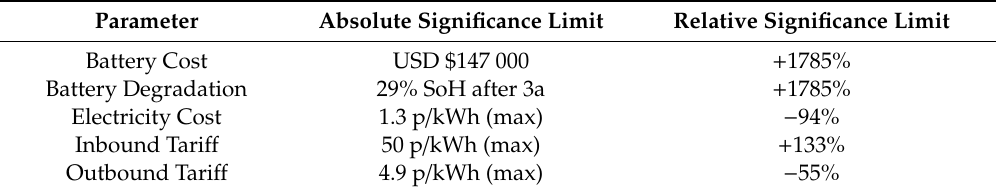
Table 6. Results of a sensitivity study of the V2G results with respect to key